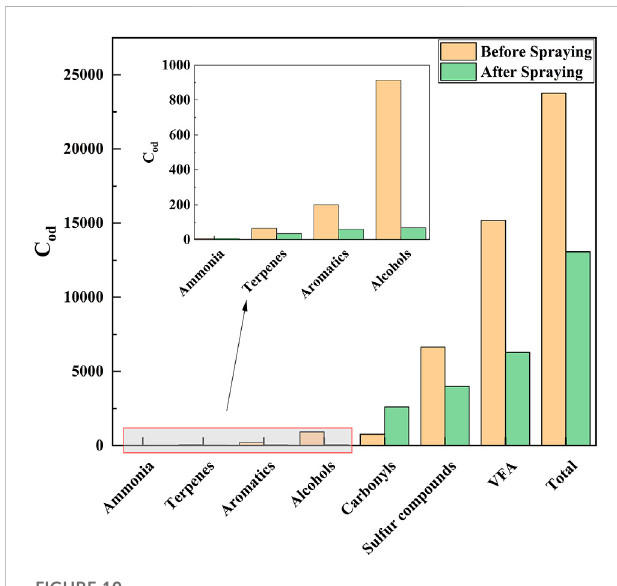
FIGURE 10 C od of the total and each group before and after